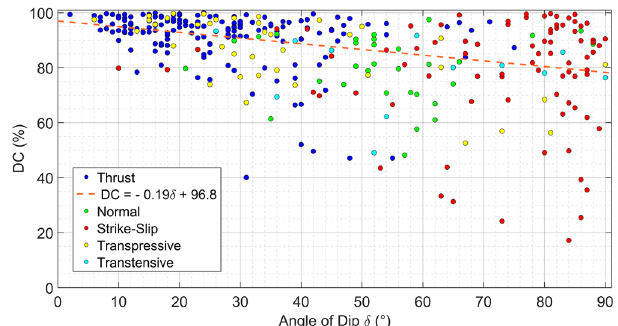
Fig. 5 Distribution of DC components as a function of the angle of dip, δ , for large (M w ≥ 7.0) shallow (hypocentral depth within 50 km) earthquakes in the GCMT catalogue (1990 – 2021). More than three hundred events are considered and a clear trend, although weak and with large scattering of data, indicates the DC values are negatively correlated to the angle of dip. The best linear fi t is given by DC = − 0.19 δ + 96.8. This effect has origin in the different composition of the seismic pattern used for moment tensor inversion and must be considered for a correct interpretation of results shown in the previous fi